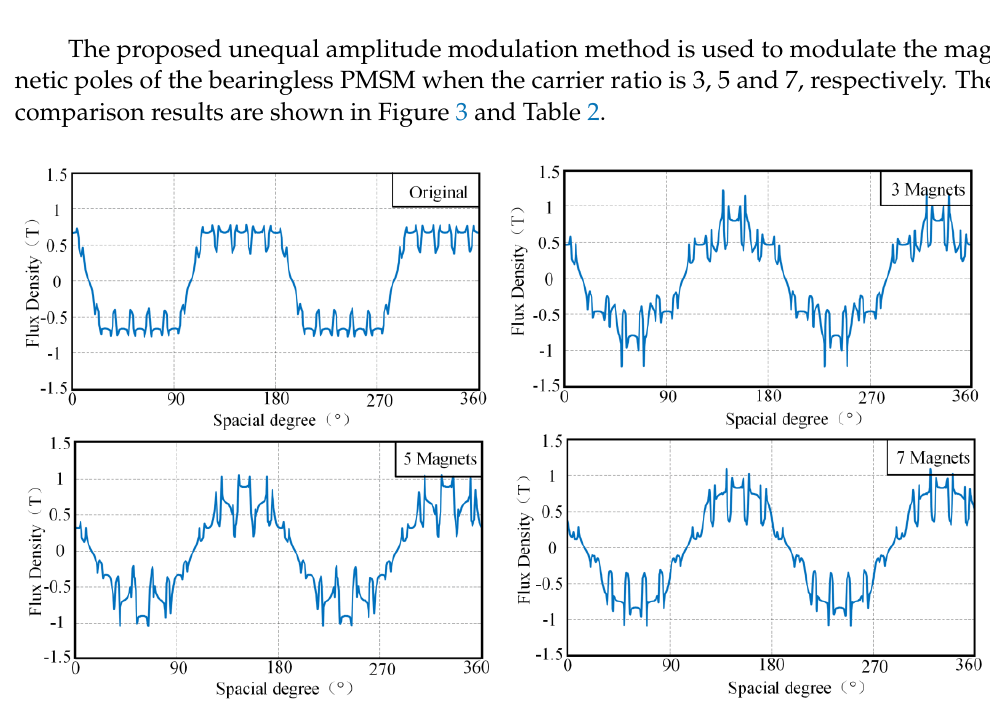
Figure 3. Comparison of no−load air−gap flux density waveforms of motors with different carrier ratios.